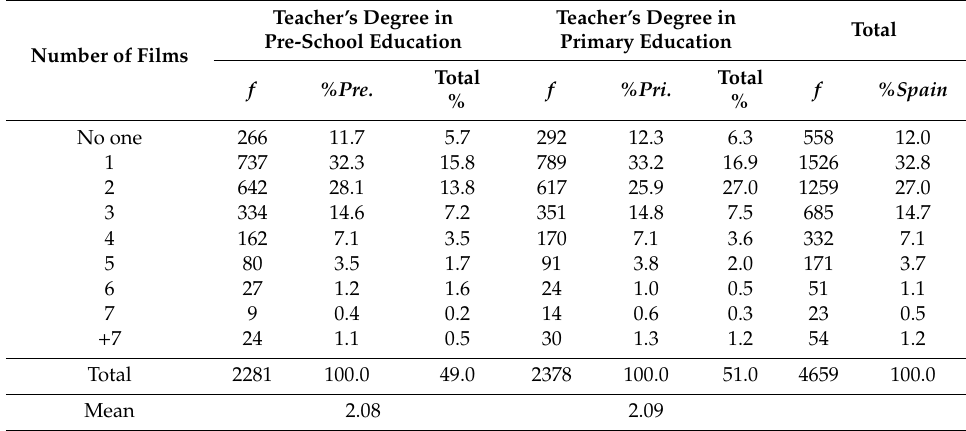
Table 3. Number of films watched per week by the teacher (cid:48) s degree students, according to the type of degree.